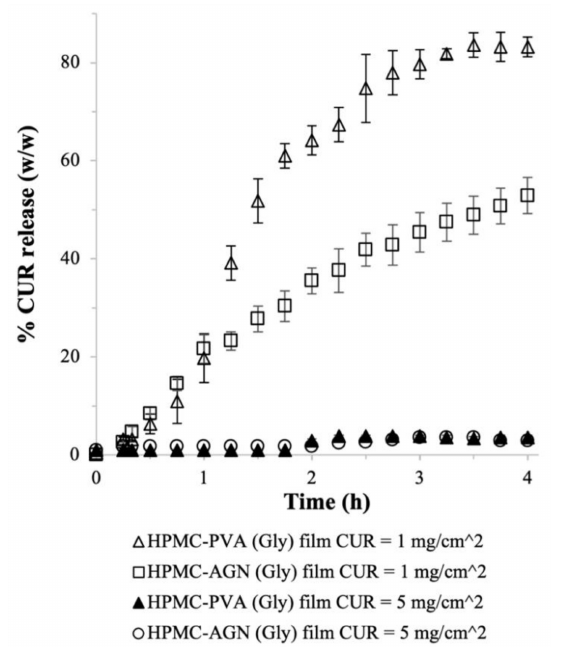
Figure 3. CUR release from HPMC–PVA (Gly) and HPMC–AGN (Gly) films ( n = 6, error bars represent the standard